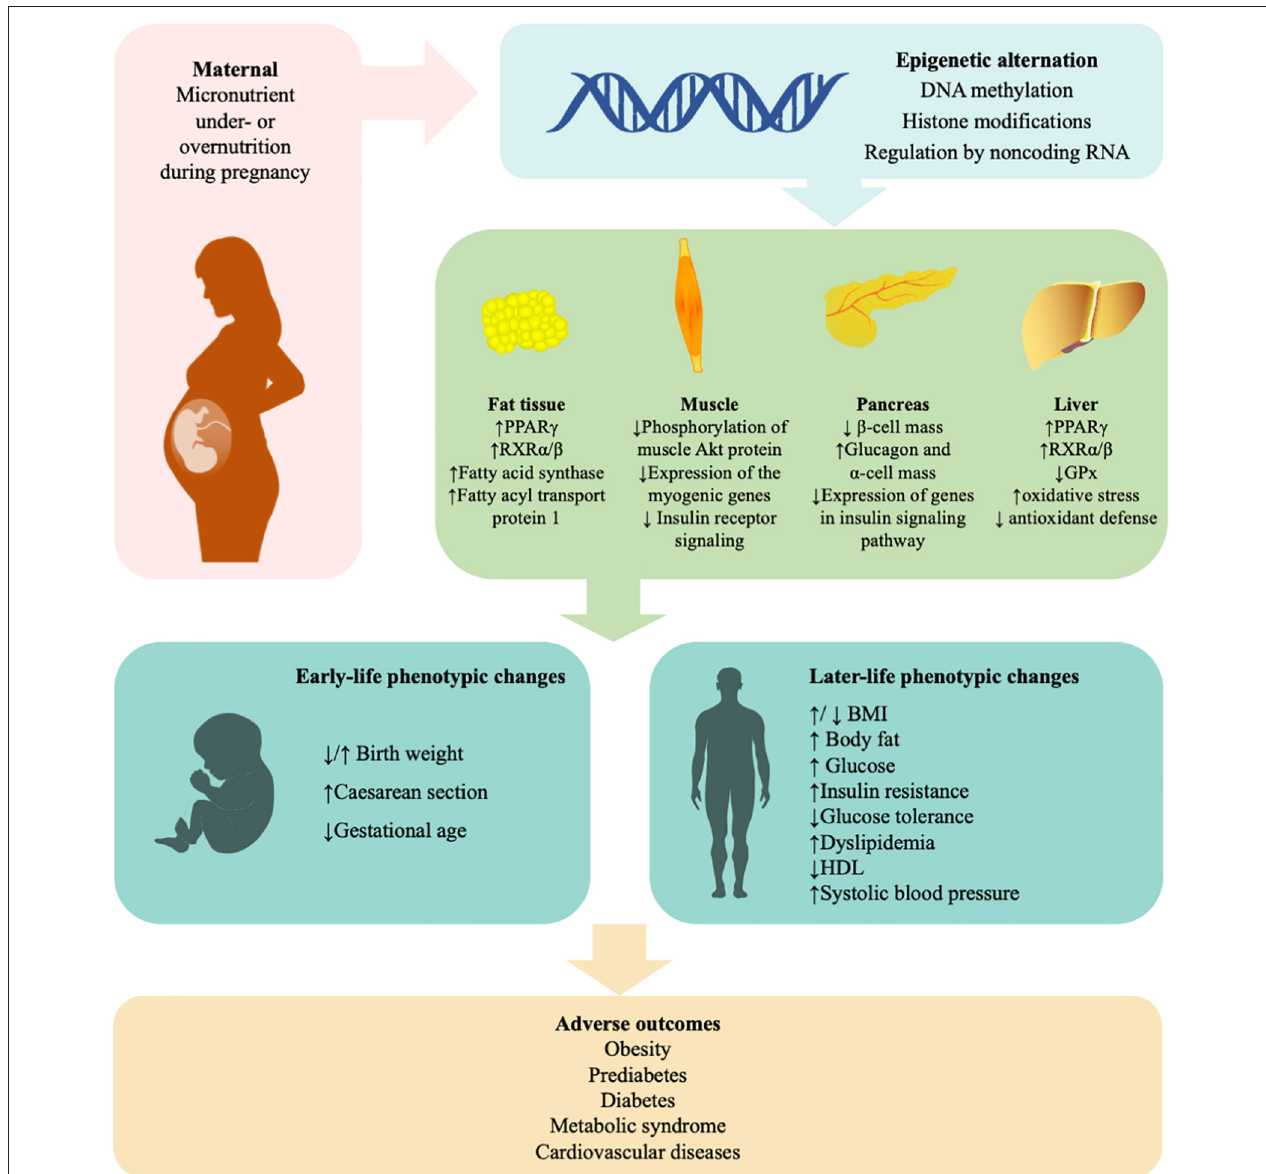
FIGURE 1 | Mechanisms in the effects of maternal micronutrient on glucose metabolism of offspring. “Fetal programming” suggests that maternal micronutrient is linked with the susceptibility of insulin resistance, glucose intolerance, obesity, and type 2 diabetes in offspring. Epigenetic mechanisms, including DNA methylation, histone modifications, and microRNA, play a critical role in the process. Supplement of minerals and vitamins under medical guides will be beneficial to subsequent generations. BMI, body mass index; GPx, glutathione peroxidase; HDL, high-density lipoprotein; PPAR γ , peroxisome proliferator-activated receptor gamma; RXR, retinoid X receptors. ↑ , increased; ↓ ,